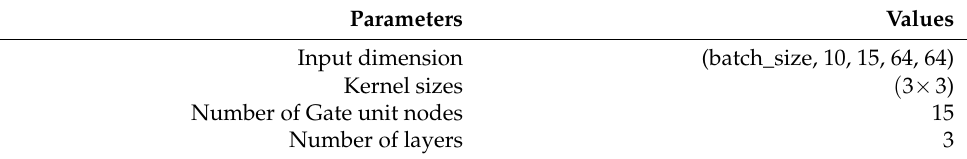
Table 1. Parameters of model.